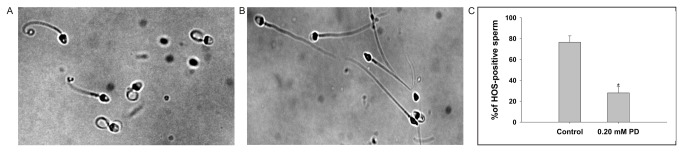
The HOS responsiveness of the sperm, as indicated by tail coiling.(A) The untreated control sperm and (B) sperm from the same man that had been treated with 0.20 mM PD were examined under a phase contrast microscope (injector: 20×). (C) The majority (76.5%) of the untreated control sperm were HOS-positive, whereas only 28.0% of the PD-treated sperm were HOS-positive. The data represent the means ± SEM (n=6). *:Significantly different from the control, p<0.05.